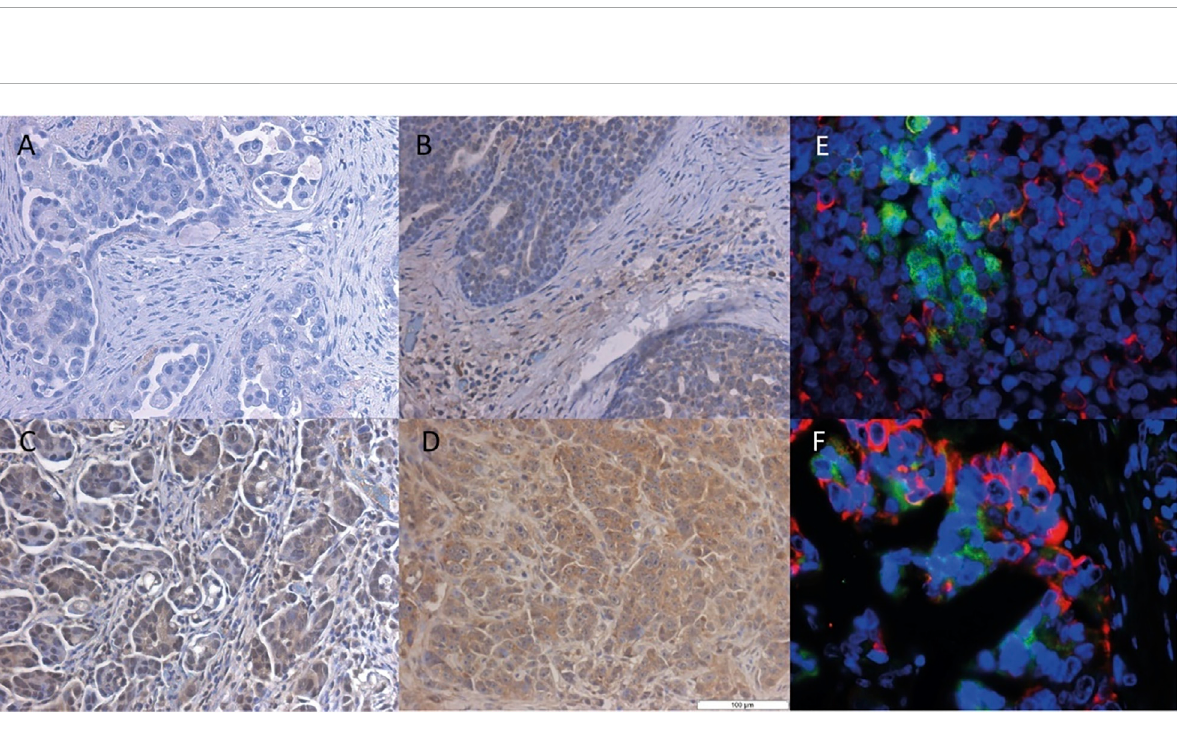
FIGURE 3 Immunohistochemical staining of the OATP4A1 protein in FFPE samples from HGSOC. Representative IHC staining of ovarian cancer cells with different levels of SLCO4A1/OATP4A1 protein in FFPE samples images (B – D) ; the negative control FFPE sample is shown in image (A) . Immuno fl uorescence staining of OATP4A1 and CK19 is shown in images (E – F) Red fl uorescence indicates cytokeratin-19 and green fl uorescence OATP4A1; blue indicates DAPI staining of nuclei (magni fi cation